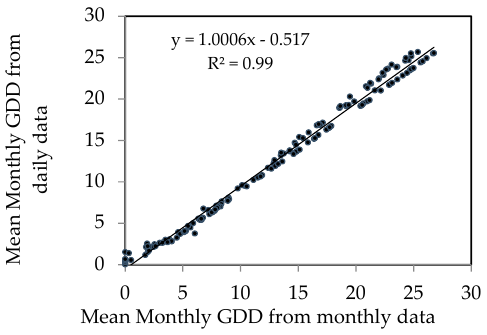
Figure 2. The relationship between mean monthly GDD from monthly data and mean monthly GDD from daily data.